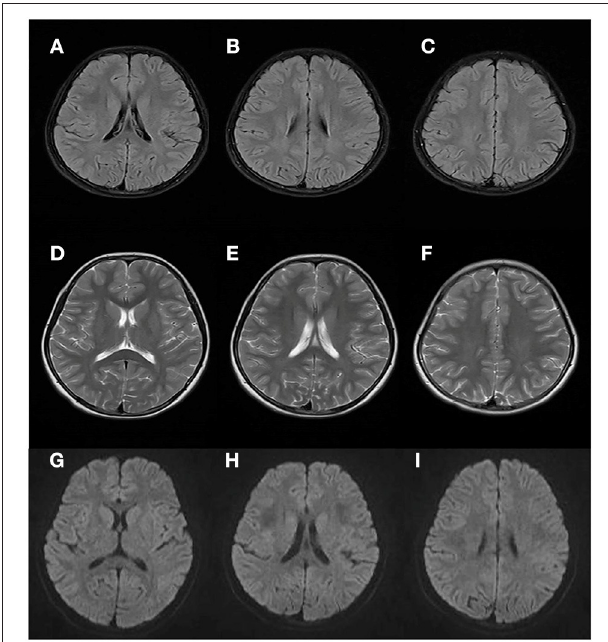
FIGURE 2 | Brain MRI performed 45 days after the first attack. Results showed almost complete regression of the WM abnormalities (compared with Figure 1 ).